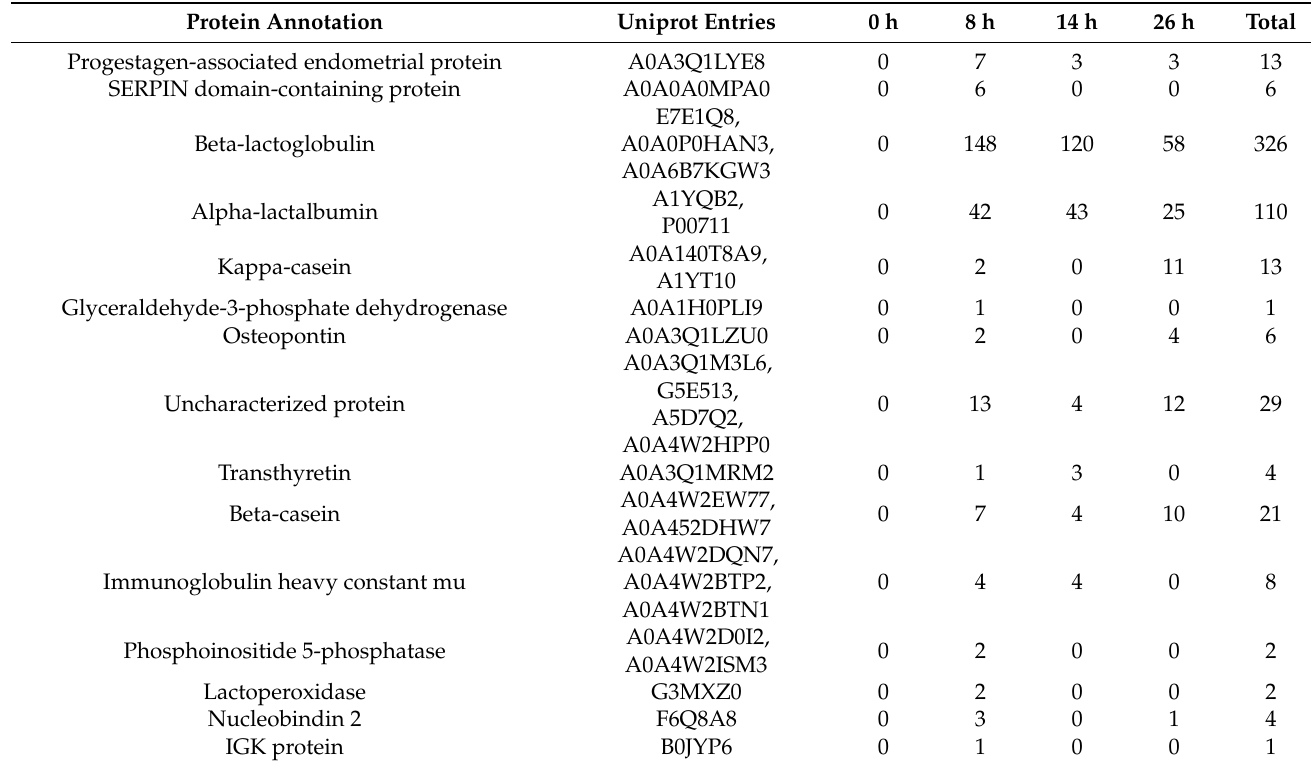
Figure 1. Primary mass spectrometry of peptides in samples of different fermentation times. Table 2. Identified peptides in samples from different fermentation times.